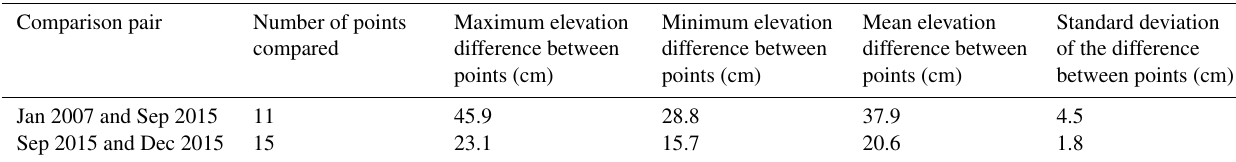
Table 2. Points used to compare each pair of DSMs.